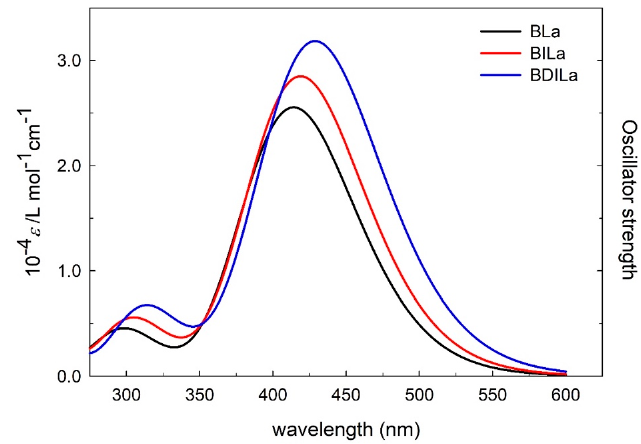
Figure 3. The simulated UV-Vis spectrum of BLa, BILa, and BDILa in water solution.